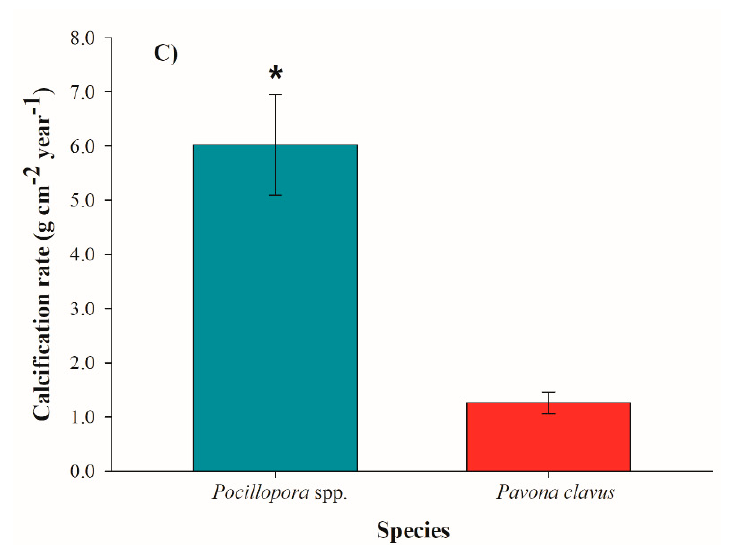
Figure 6. Annual growth parameters ( ± SD) for Pocillopora spp. and Pavona clavus . ( A ): annual extension rates; ( B ): skeletal density; and ( C ): calcification rates. Asterisks (*) denote significance differences between species ( p < 0.001).